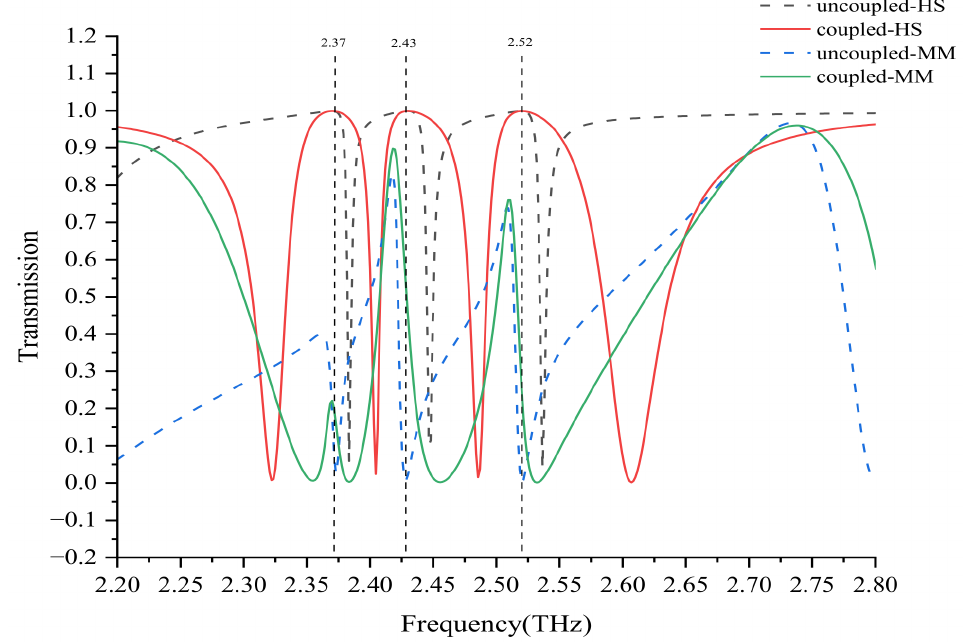
Figure 5. Comparisons of the comprehensive spectra based on the QR-DD structure and HSO model when the bright and dark modes are in the coupled and uncoupled states, respectively. Transparent windows are formed in the spectra when the bright and dark modes of the two models interact in a destructive manner. If the modes are in an uncoupled state, the bright and dark modes exist separately in the spectra. In the HSO model, the intrinsic frequencies ω j ( j = a , b , c ) of the passive oscillator were reset to 2.3, 2.43, and 2.57 THz, respectively, and these frequencies corresponded